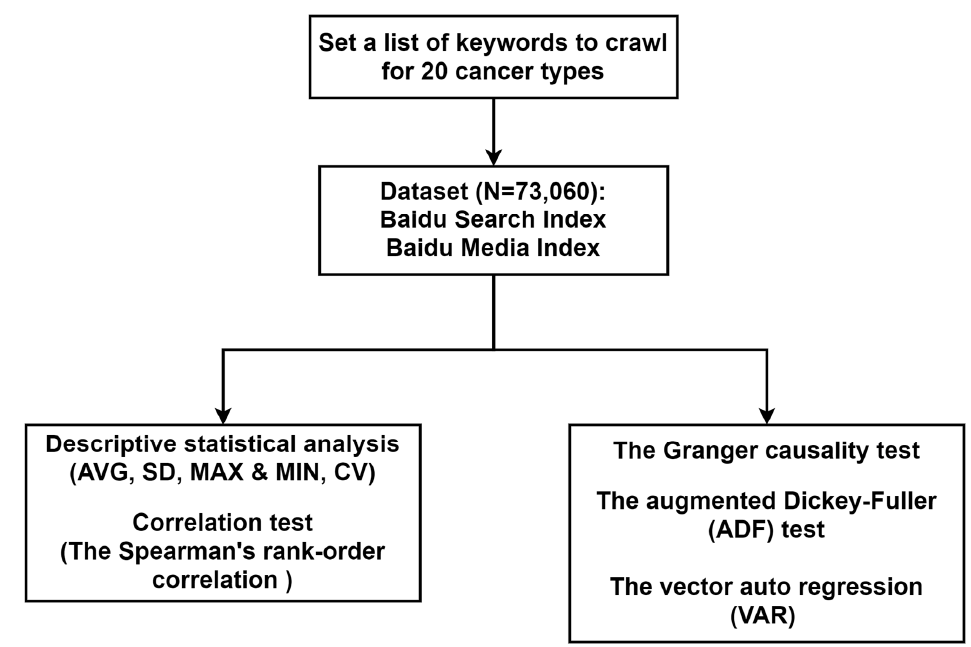
Figure 1. The flowchart of data obtaining and